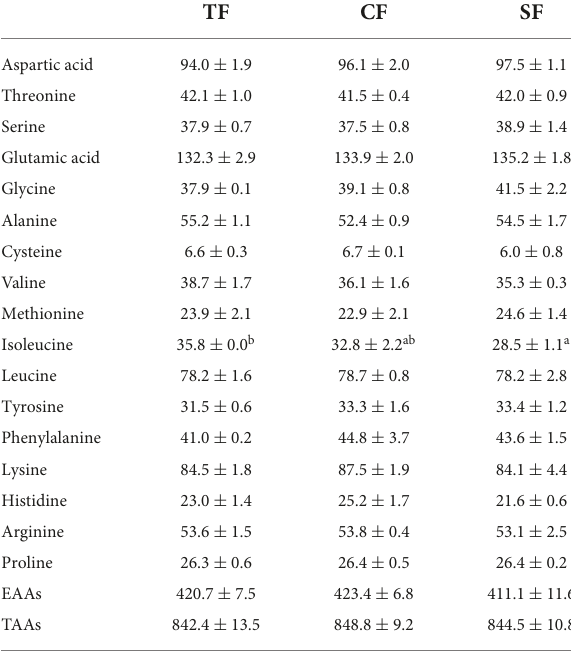
TABLE 6 Flesh amino acid composition of largemouth bass fed trash fish and formula feeds (DM basis, g/kg).